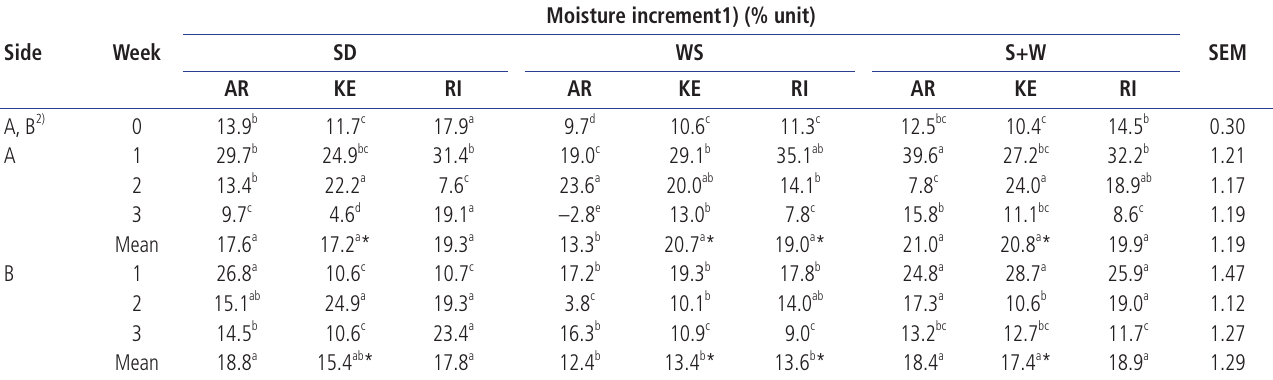
Table 8. Effects of bedding materials by the species of pine trees and pen location on moisture increment of beddings for rearing Hanwoo Side